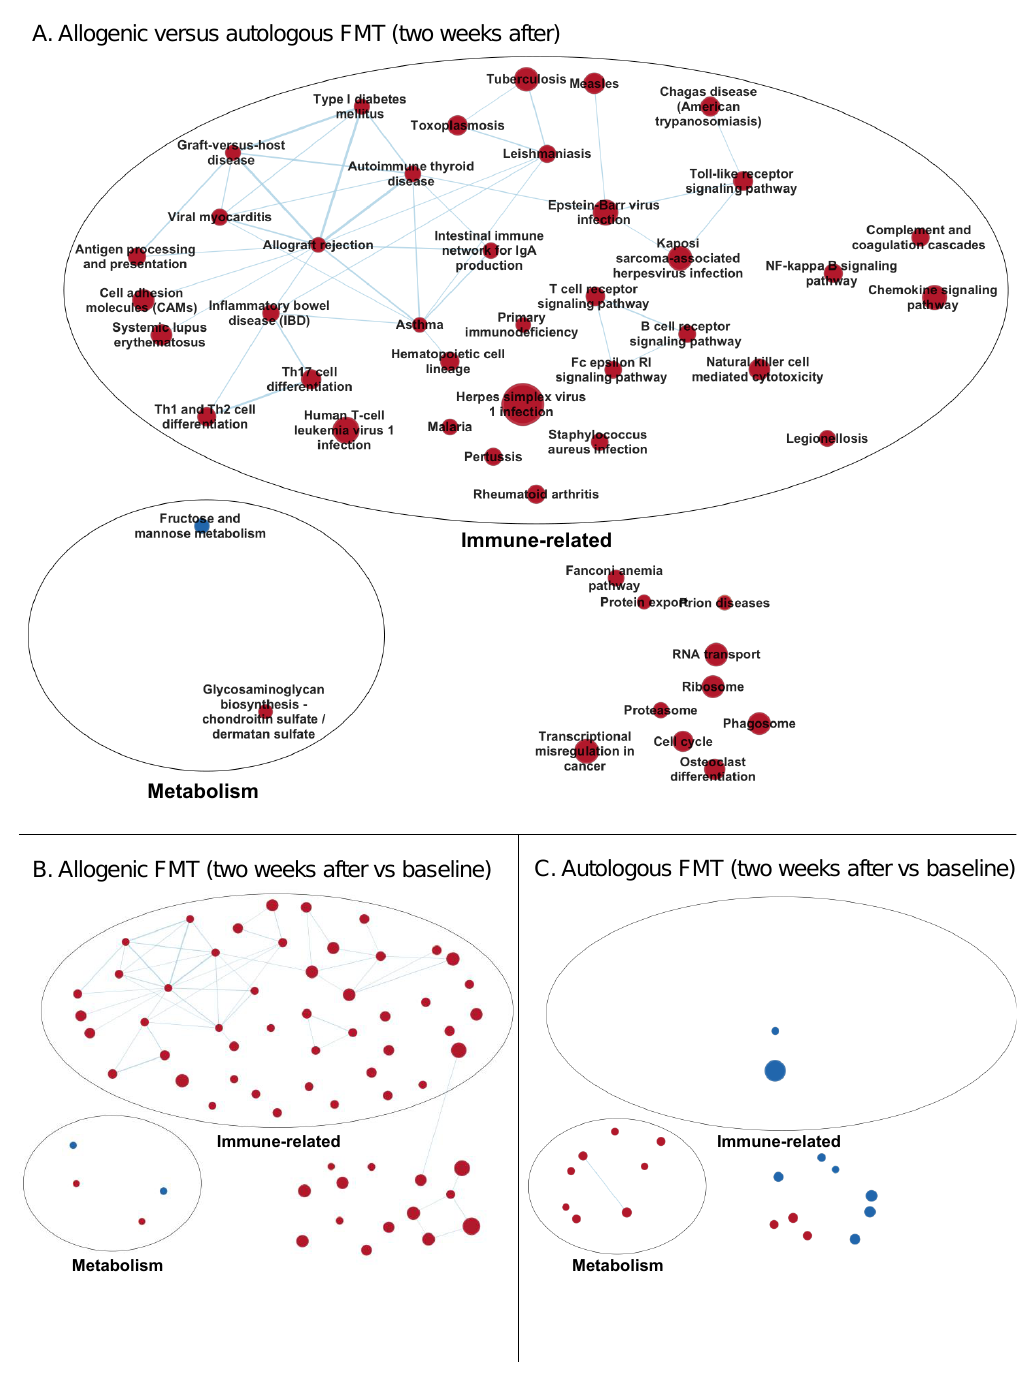
Figure 2. Enrichment maps of the gene set changes two weeks after FMT. ( A ) Allogenic versus autologous FMT (baseline-corrected). ( B ) Allogenic FMT (within-group comparison). ( C ) Autologous FMT (within-group comparison). Nodes represent KEGG gene sets, and the edges between the nodes represent their similarity. Red nodes indicate enriched (increased expression of) gene sets, and blue nodes indicate suppressed (decreased expression of) gene sets. Node size represents the number of genes in the gene set, and the thickness of the edges indicates the degree of overlap between the two connected gene sets (nodes). The gene sets are manually grouped according to their biological functions among these gene sets. See Supplemental Figure S1 for the enrichment map including all the names of the gene sets. Gene sets that were di ff erentially regulated (FDR < 0.25) between the allogenic and autologous FMT after two weeks were used as input for the enrichment map, and for better visualization, only the gene sets with FDR < 0.05 from the three depicted comparisons are